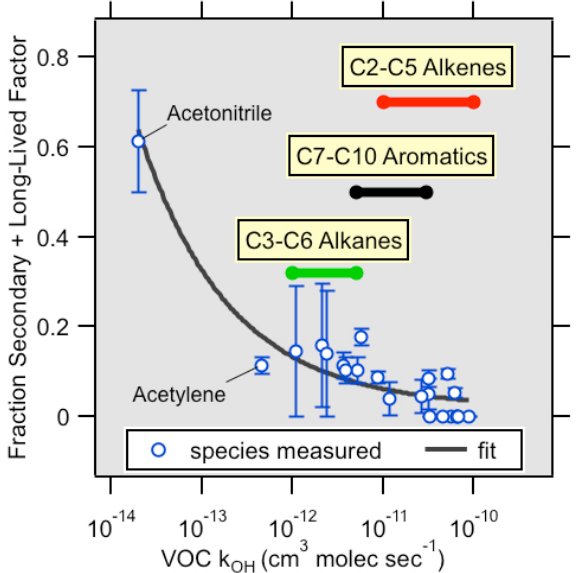
Figure 14. PMF apportionment of measured compounds to the secondary + long-lived factor plotted versus photochemical lifetime ( k OH ) (Atkinson and Arey, 2003). Longer lifetimes are associated with higher secondary+long-lived source apportionment. Colored bars represent the range of lifetimes by compound class for alkanes (green), aromatics (black) and alkenes (red). Error bars represent variability in apportionment due to PMF FPEAK parameter from − 3 to